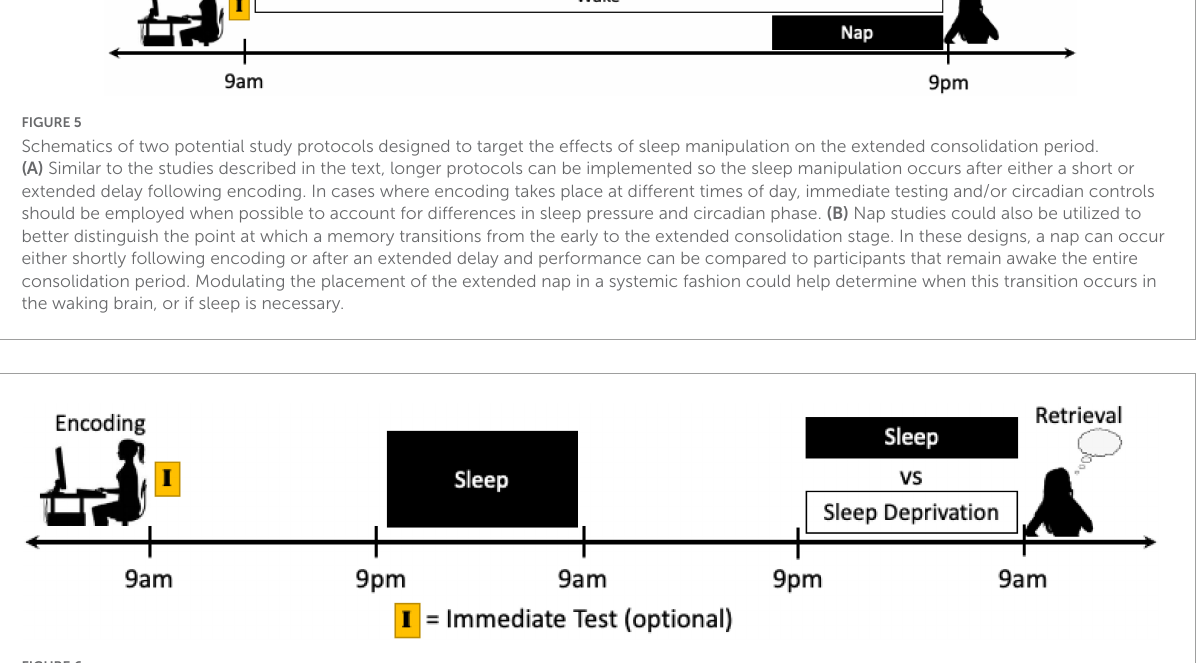
FIGURE6 Schematics of a potential study protocol designed to isolate the influence of sleep just prior to retrieval on emotional memory performance. Participants can complete an encoding task and after a night, or multiple nights, of sleep to ensure that memories have transitioned to the extended consolidation stage, sleep can be manipulated just prior to retrieval. In this way, sleep vs. sleep loss can specifically target the retrieval of emotional memories while also controlling for circadian rhythm and time of day effects. Moreover, an immediate test directly after encoding can be used to determine within-subject memory changes due to the different conditions, however it must be kept in mind that the testing of memory itself may influence subsequent memory performance (see Footnote 4 and section